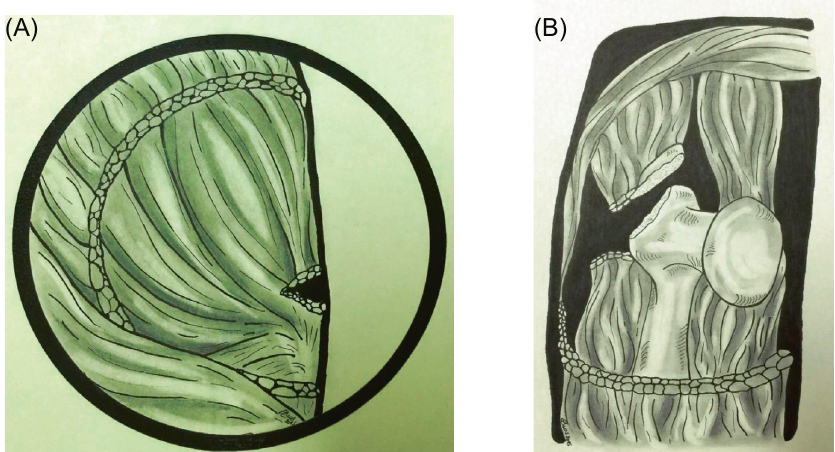
Figure 1. Lesions were classified intra-operatively. (A) Types I and III: the abductor mechanism has partial rupture with trochanteric displacement (<2.5 cm). (B) Types II and IV: the abductor mechanism is discontinuous (total rupture) with a trochanteric displacement (>2.5